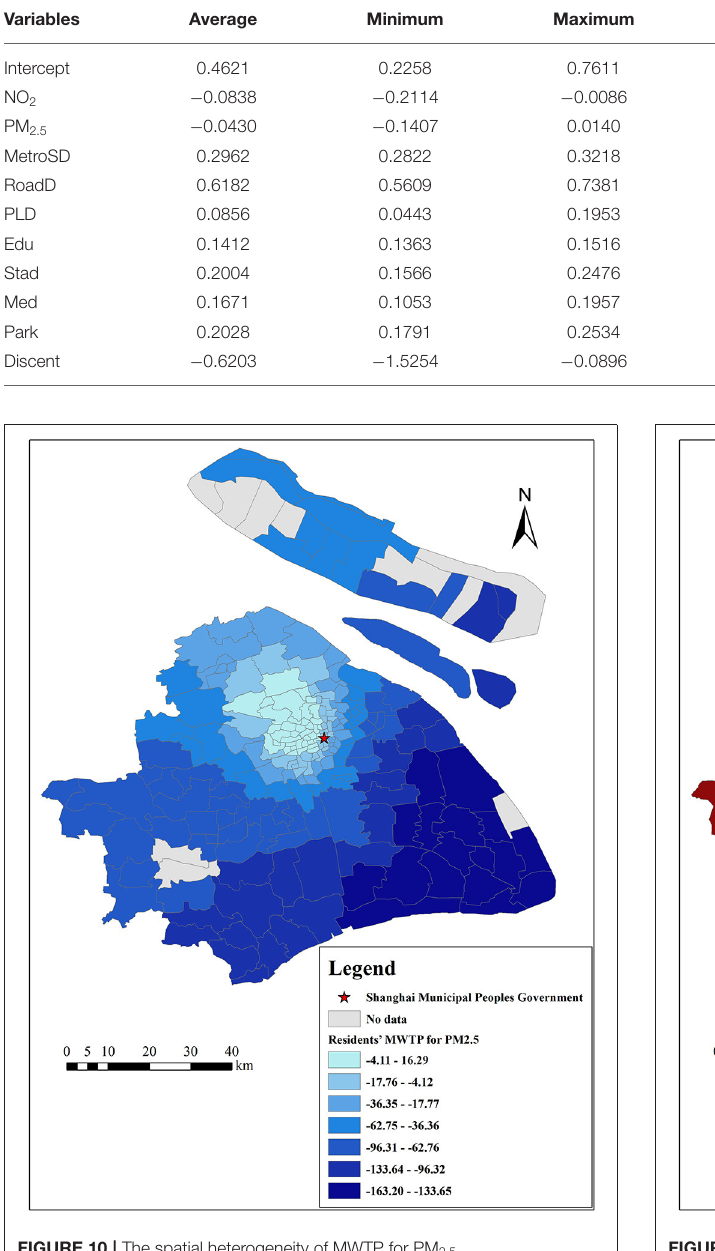
FIGURE 10 | The spatial heterogeneity of MWTP for PM 2.5 . FIGURE 11 | The spatial heterogeneity of MWTP for NO 2